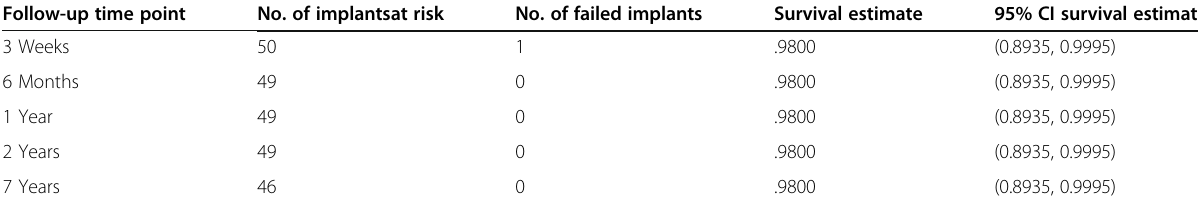
Table 3 Kaplan – Meier survival analysis: 7 years of follow-up Follow-up time point